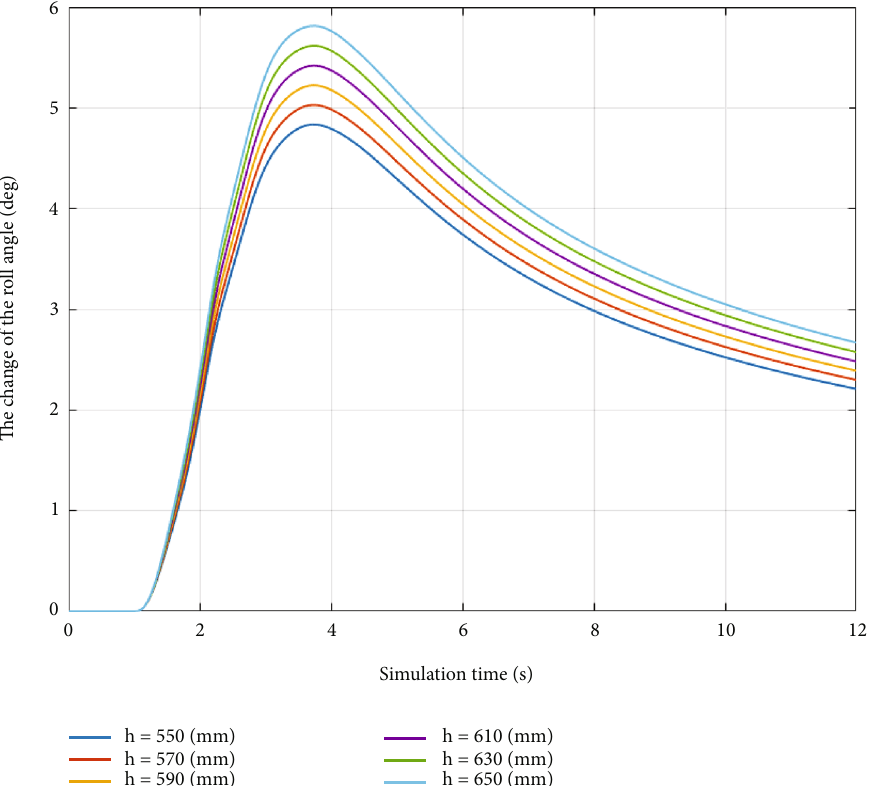
Figure 6: The change of the roll angle (the fi rst case — distance